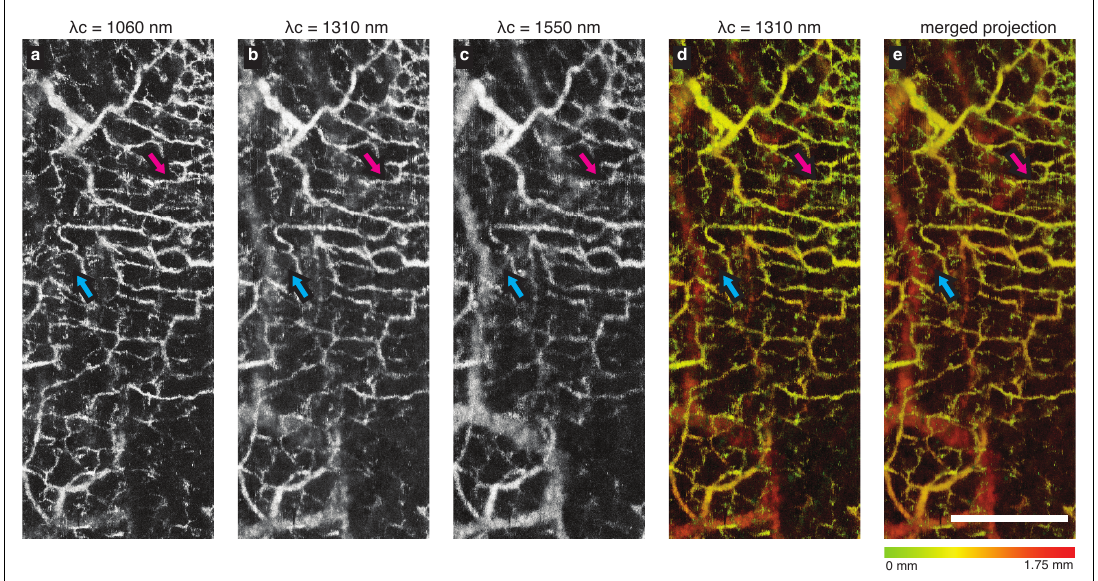
Figure 3. The vascular projections acquired from the bands centered at ( a ) 1060 nm, ( b ) 1310 nm, and ( c ) 1550 nm are shown. Projections were obtained using a colormap to encode the depth of the vessel, in ( d ) imaging band at 1310 nm, and ( e ) combining all three imaging bands. The magenta arrows mark the superficial vessel that is best captured by the 1060 nm system. The blue arrows mark the deeper vessel that is best captured by the 1550 nm system. Scale bar = 1